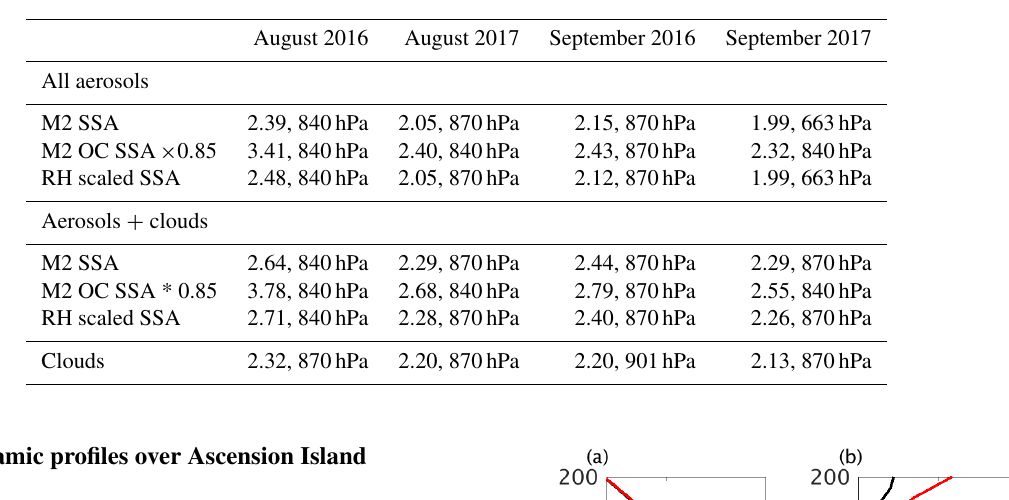
Table 3. Monthly mean maximum heating rate within the column due to clouds and aerosols in kelvin per day and the pressure where the maximum occurs.